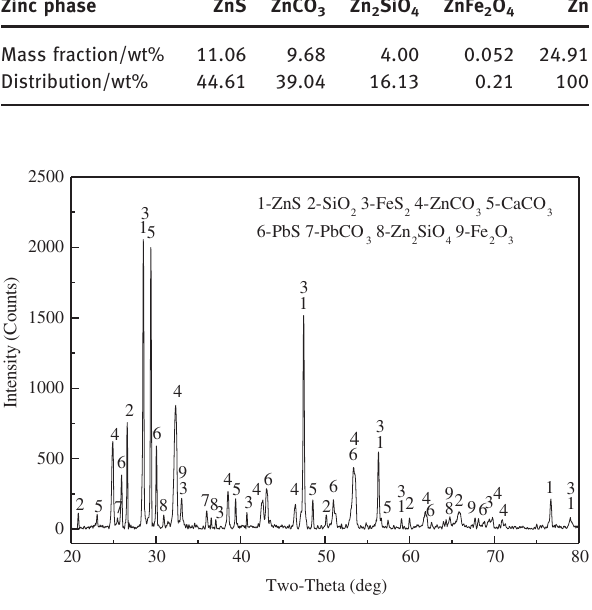
Table 2: Mineralogical analysis of oxide – sulphide zinc ore. Zinc phase